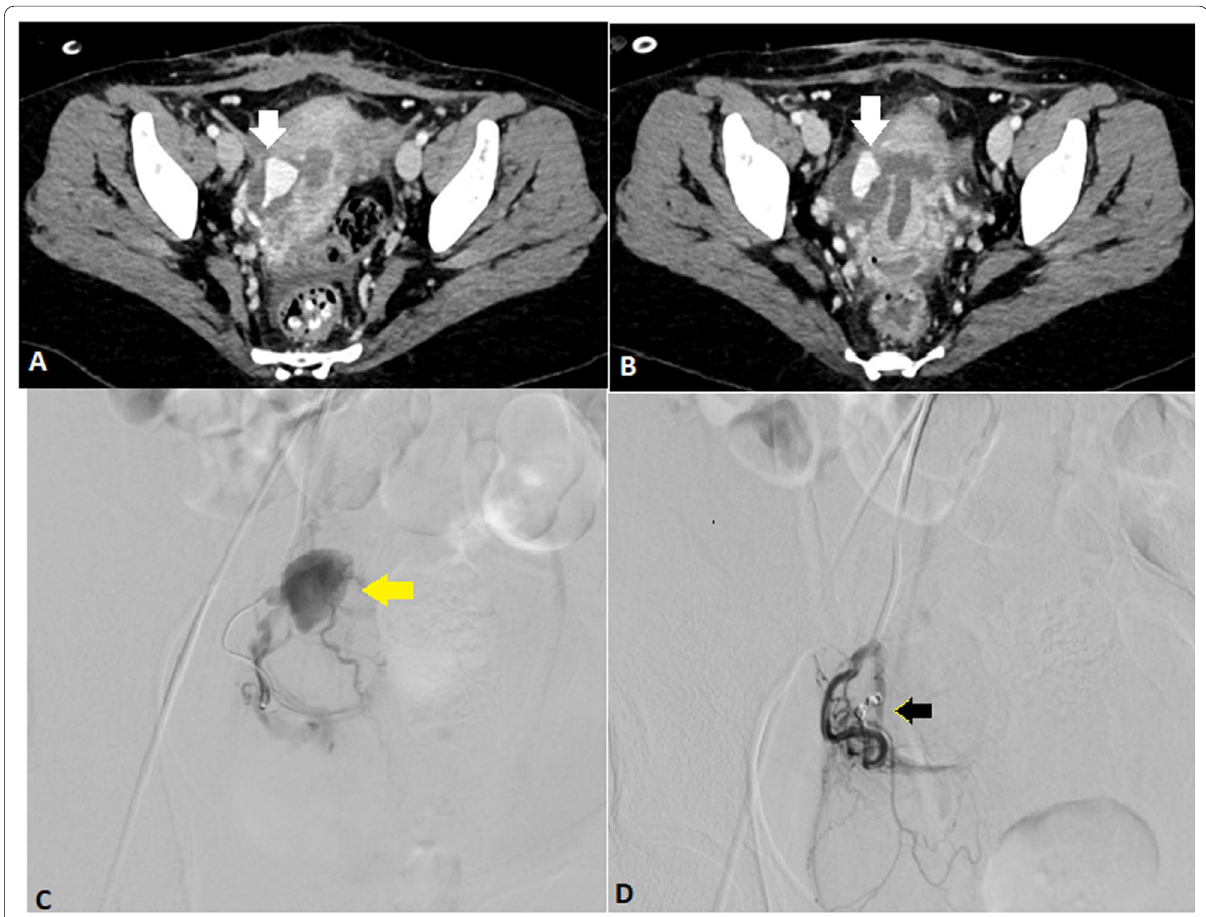
Fig. 5 Acquired pseudoaneurysm and AVM in a 32-year-old. The patient had massive vaginal bleeding after therapeutic D&C for GTC four weeks earlier. A , B Post-IV contrast CT angiogram image arterial phase showing mildly bulky uterus with partially thrombosed right uterine artery pseudoaneurysm abutting slightly widened scar site in the lower uterine segment (white arrow), with early venous drainage suggesting AVM. C Right internal iliac arteriogram redemonstrated a large narrow neck right uterine artery pseudoaneurysm (yellow arrow) measuring 35 with a neck of 2.5 mm. Adjacent arteriovenous shunting with the branches of the right uterine artery suggesting concurrent AVM, was also noted. D Post-embolisation image (performed with the combination of PVA particles and micro-coils (black arrow) since distal/efferent branch could not be selectively cannulated) showed flow stasis without any antegrade or retrograde